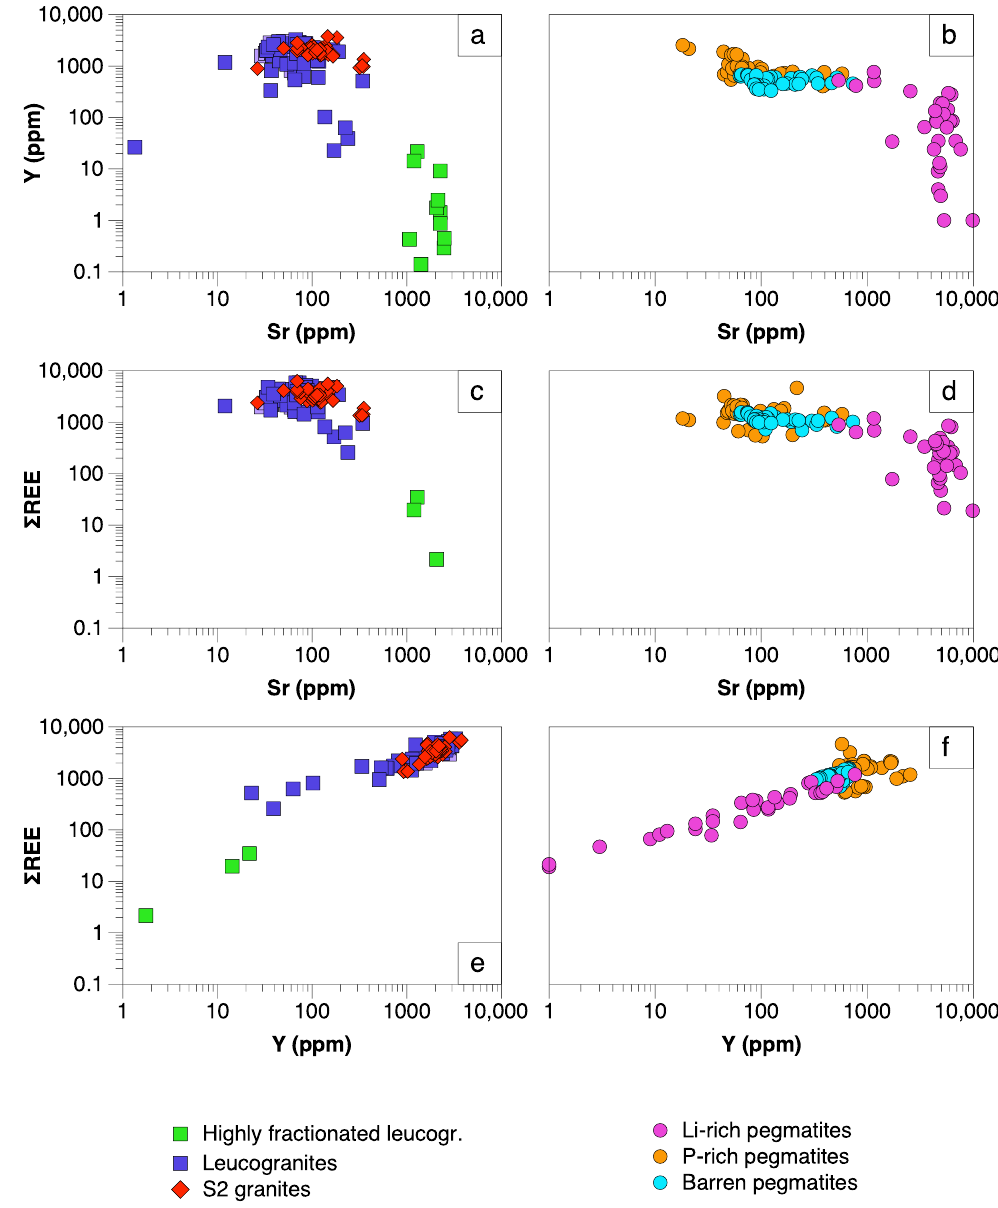
Figure 7. Binary plots of main trace elements in apatite (all values in ppm): ( a , b ) Sr versus Y; ( c , d ) Sr versus ΣREE; ( e , f ) Y versus ΣREE; from the different granitic and pegmatitic lithologies, respec- tively.